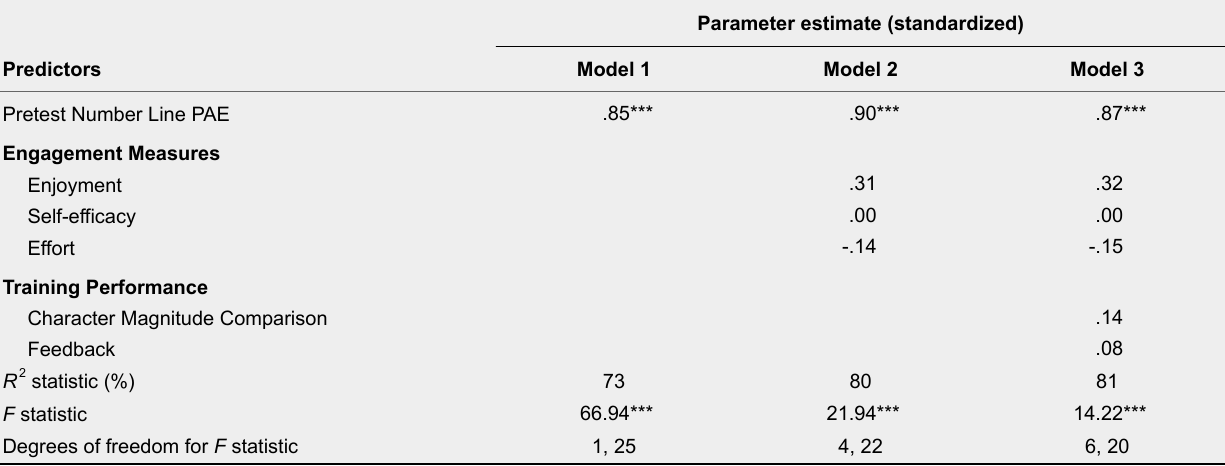
Multiple Regression Models Predicting Children’s Number Line Estimation Posttest Performance for the Number Training Condition Parameter estimate